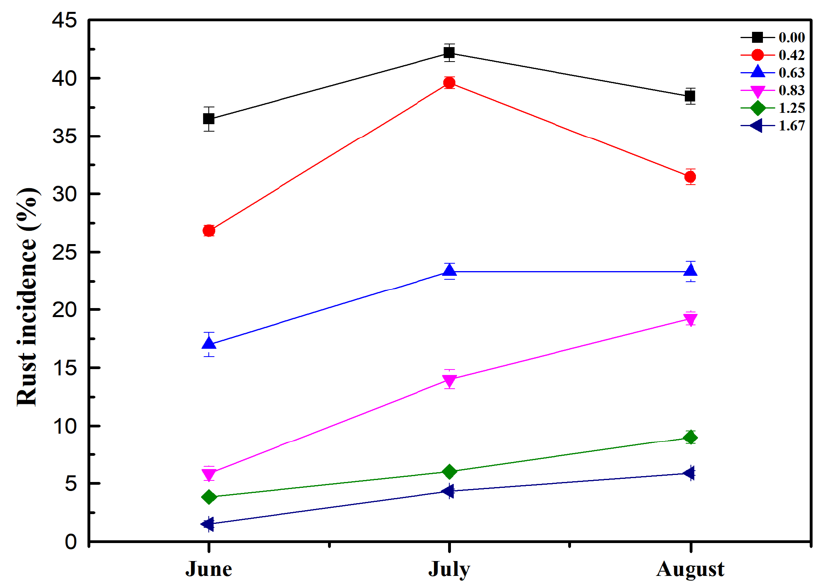
Figure 1. Rust ( Puccinia elymi ) incidence of Leymus chinensis under different grazing intensities from June to August based on the 2-year (2015 and 2016) average. Grazing intensities (0, 0.42, 0.63, 0.83, 1.25, and 1.67 cattle ha − 1 ) are indicated by different colors. The presented data are the mean of three replicates and the bars indicate standard